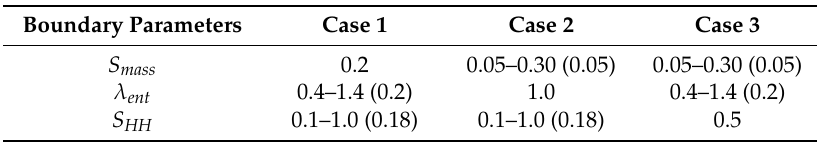
Table 5. Boundary parameters variation.